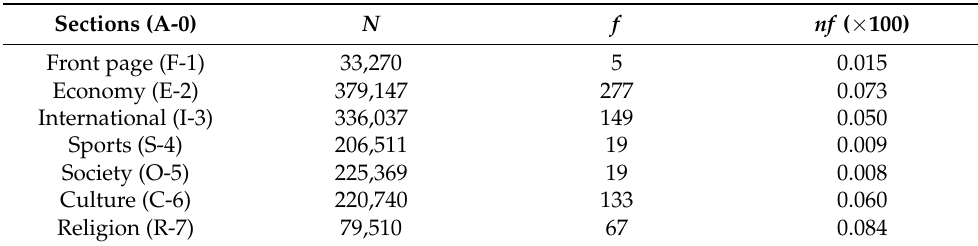
Table 4. Raw vs. normalized frequencies of the central word in multiple newspaper sections for the year 2021.